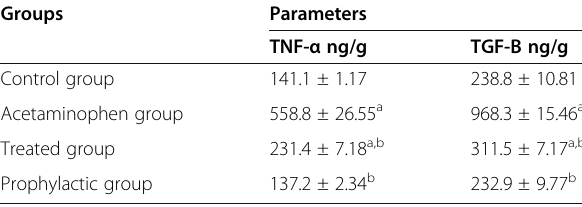
Table 4 Mean levels of TNF- α and TGF- β parameters in the different studied groups